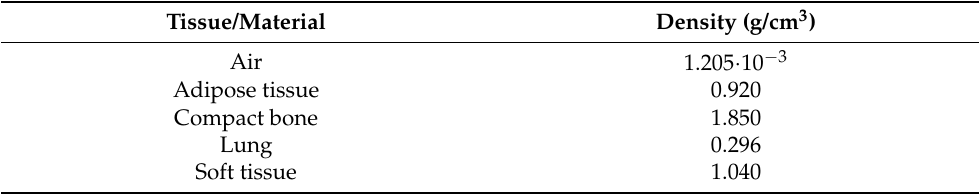
Table 3. Tissues used for the segmentation of validation